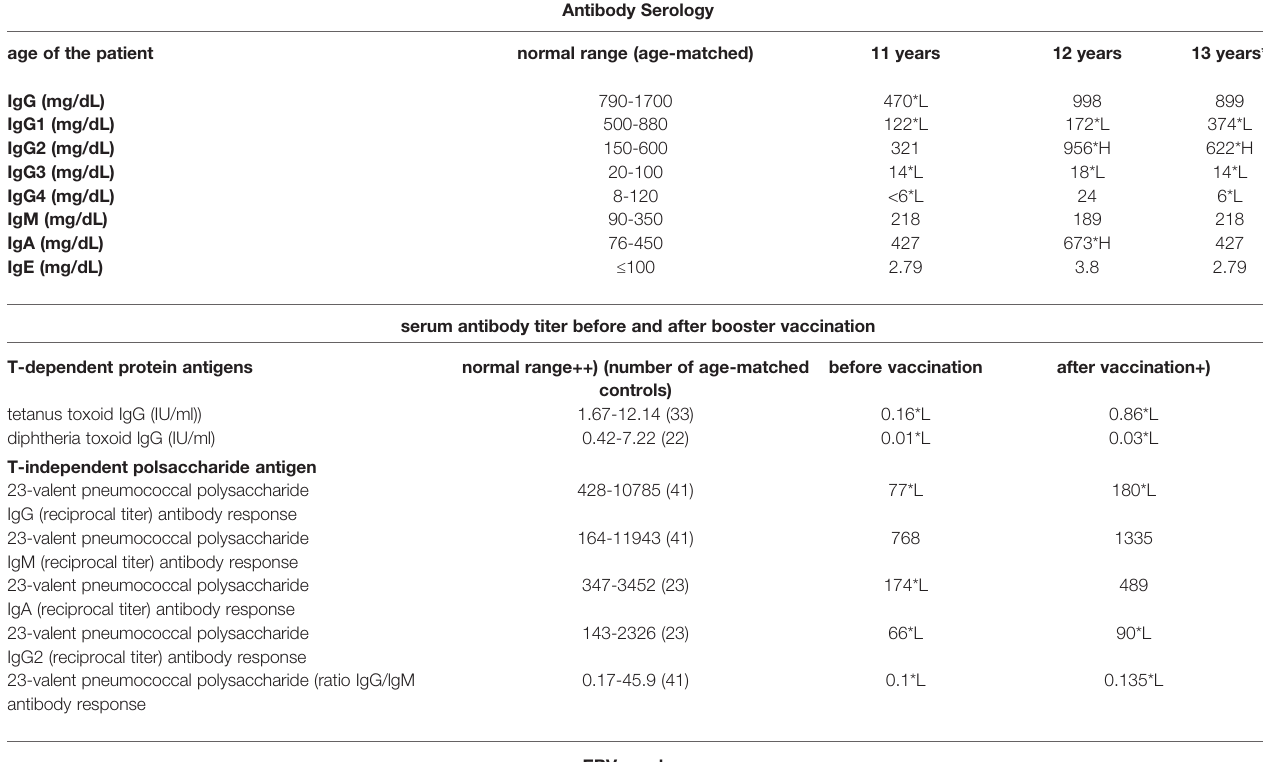
TABLE 1 | Immunological